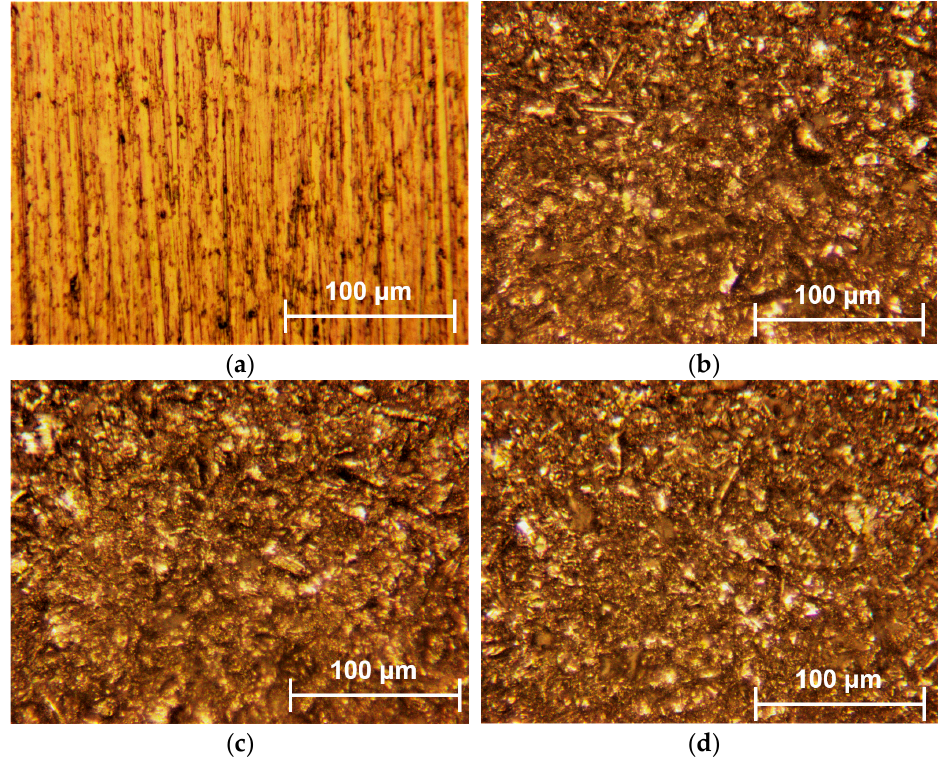
Figure 8. Optical microscopy before corrosion of S235JR for: ( a ) S235JR—non-sandblasted, ( b )— S235JR—sandblasted with quartz, ( c )—S235JR—sandblasted with garnet, ( d )—S235JR— sandblasted with alumina.